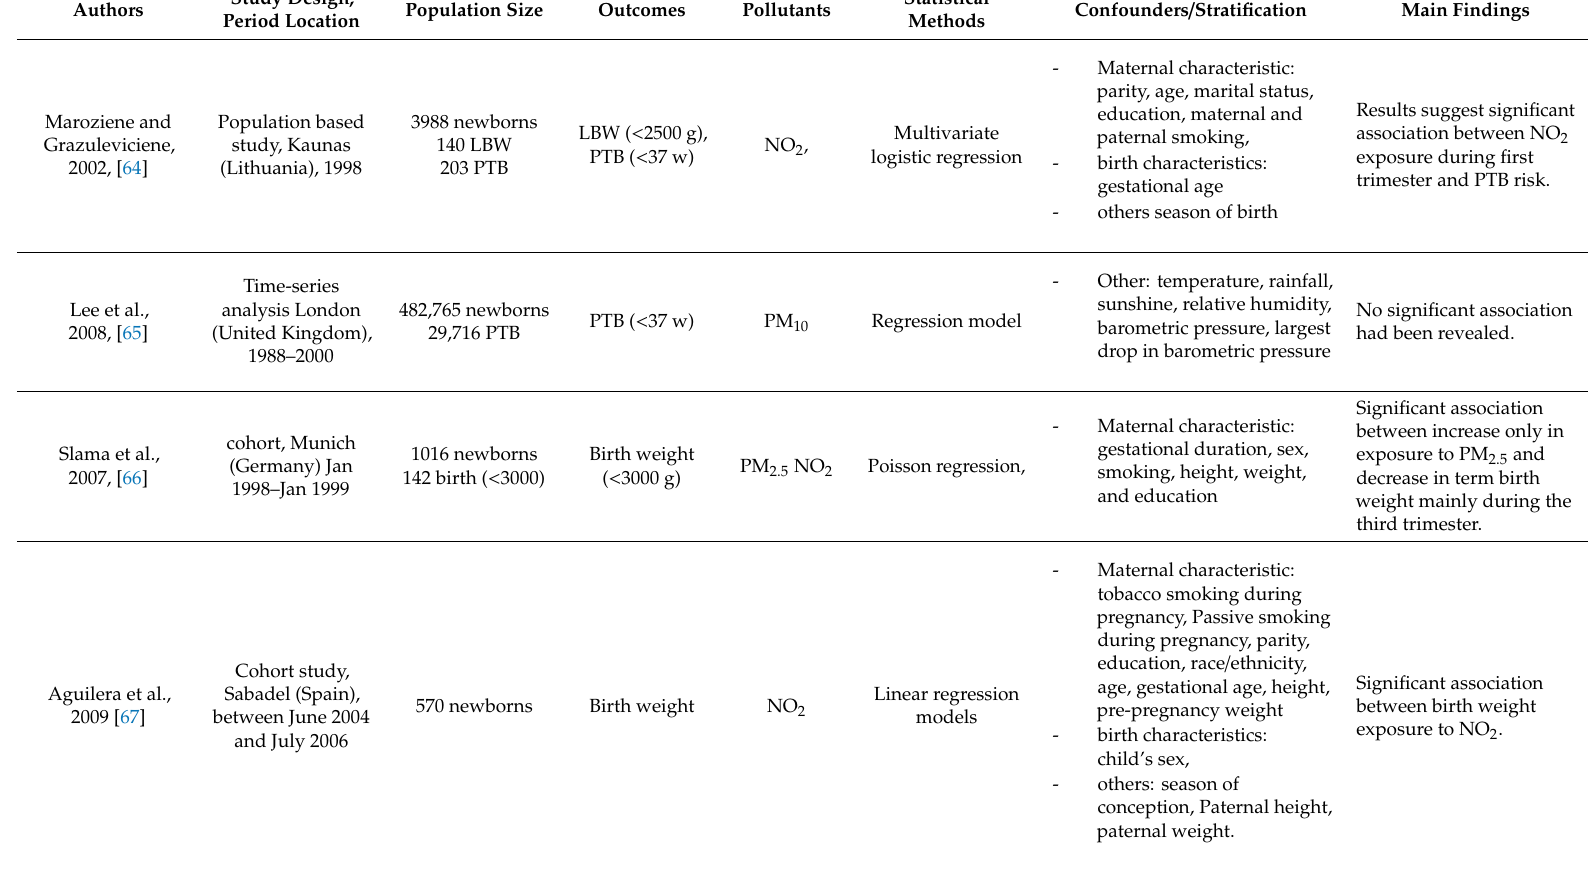
Table 1. Main characteristics of the selected studies, order by year of